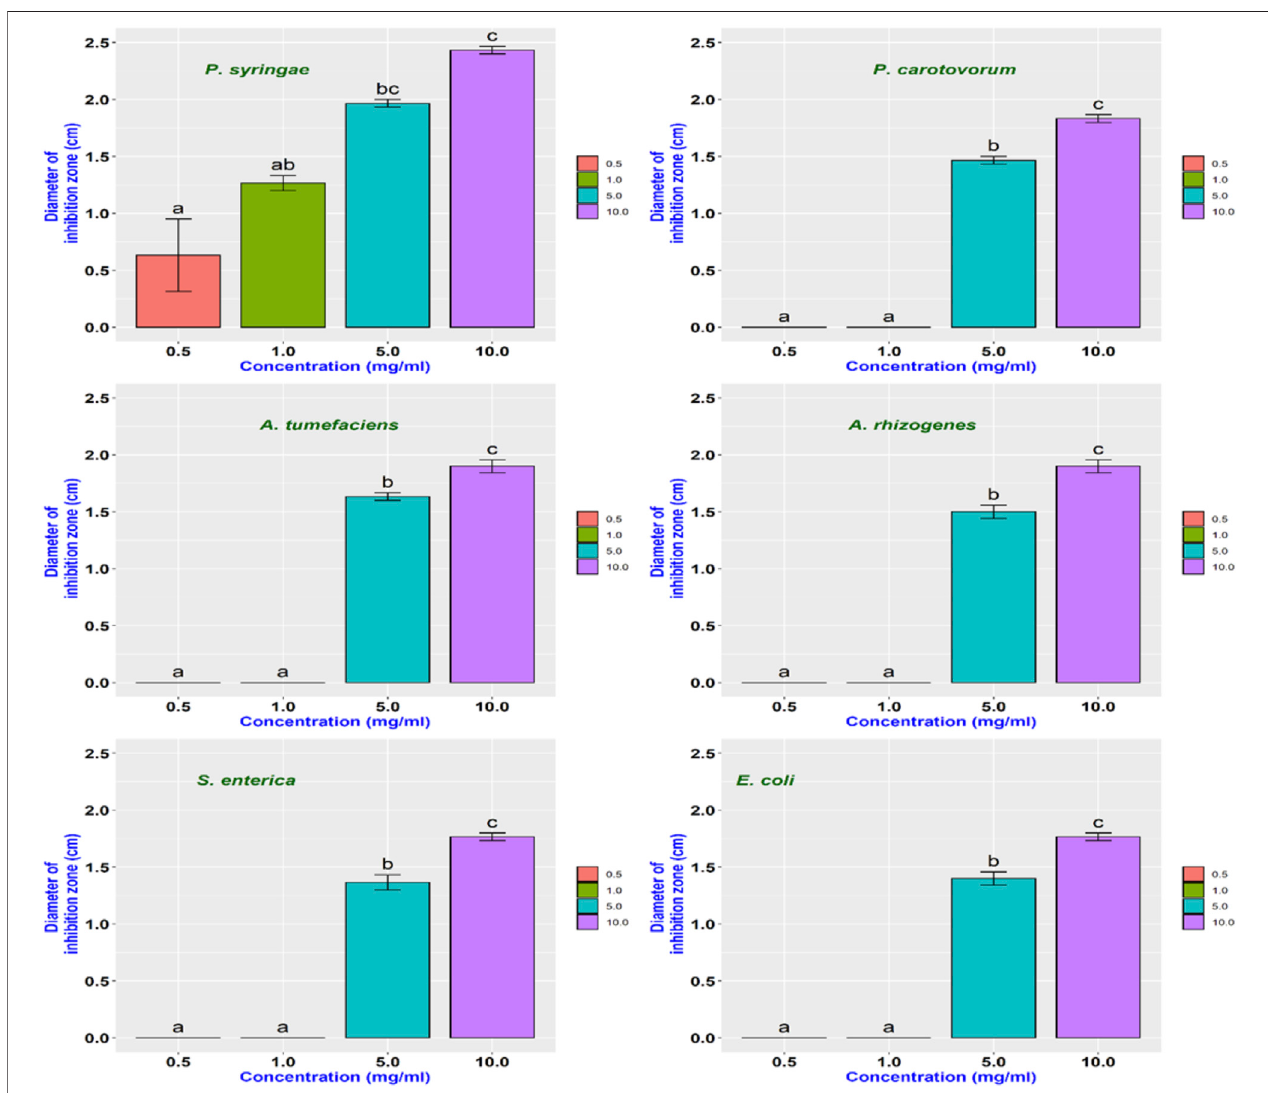
FIGURE 5 | Bar diagram representing the MIC of NH2-FCDs for different Gram-negative